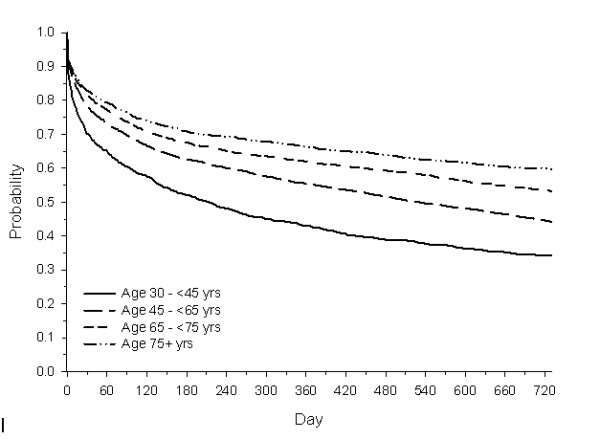
Kaplan-Meier curves for time to initiation of antihyperglycaemic therapy after diagnosis of type 2 diabetes by age group.